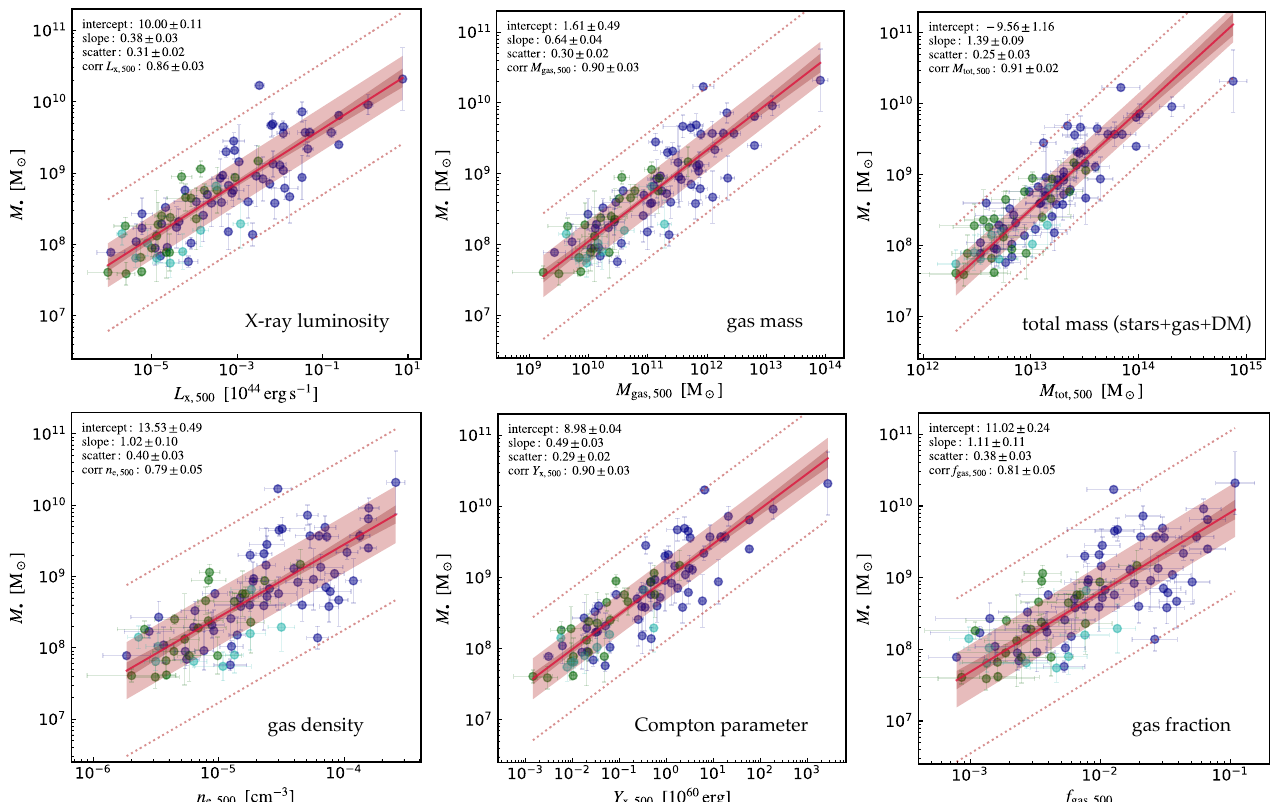
Figure 7. Scaling relations between the central (dynamical/direct) SMBH mass and key macro X-ray halo properties— adapted from Gaspari et al. [20]. Top-left to bottom-right panels : gas X-ray luminosity (in the 0.3–7.0 keV band), gas mass, total mass (dominated by the dark matter component), gas electron density, Compton parameter, and gas fraction. The extraction radius is within the macro-scale r < R 500 . The 85 circles include the observed direct/dynamical SMBH mass with the X-ray halo detected in the host galaxy groups (and a handful of clusters). The circle colors depict the morphological type of the central galaxy: elliptical/blue, lenticular/green, spiral/cyan. The employed Bayesian analysis accounts for the observed errors, providing a statistically robust estimate of the intercept and slope of the linear fitting (top-left inset). The solid red line with dark band shows the 16–84 percentile interval of the fit, while the 1- σ intrinsic scatter is shown via the wider light red band (dotted lines are the 3- σ